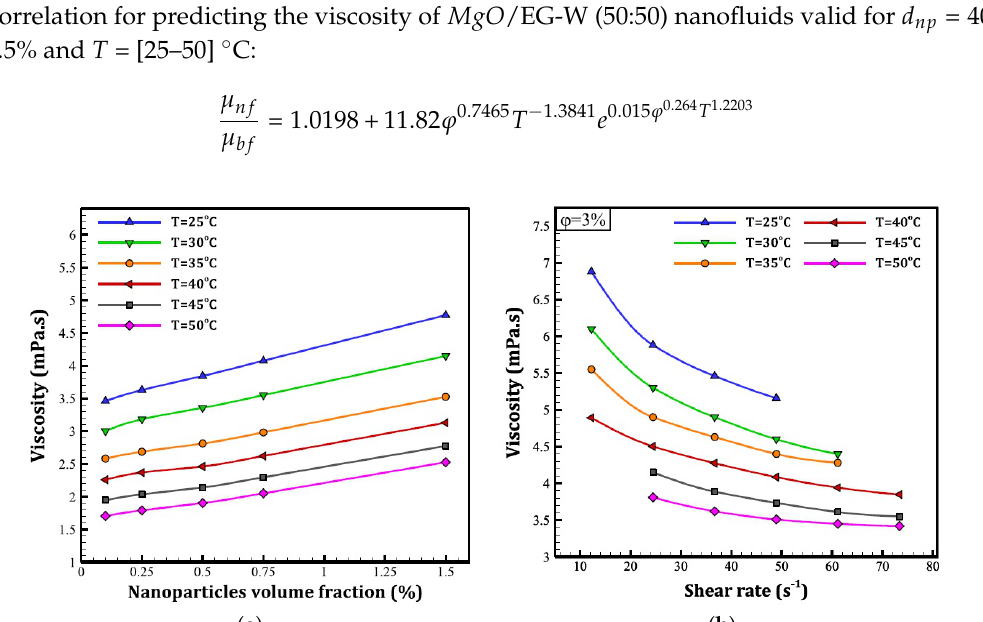
Figure 5. Dynamic viscosity of the ( a ) Newtonian ( ϕ ≤ 1.5%) and ( b ) non-Newtonian ( ϕ = 3%) nanofluid samples at different temperatures. Results obtained by Afrand et al. [72] for magnesium oxide nanoparticles dispersed in a mixture composed of water and ethylene-glycol (50:50). After [72], with permission from